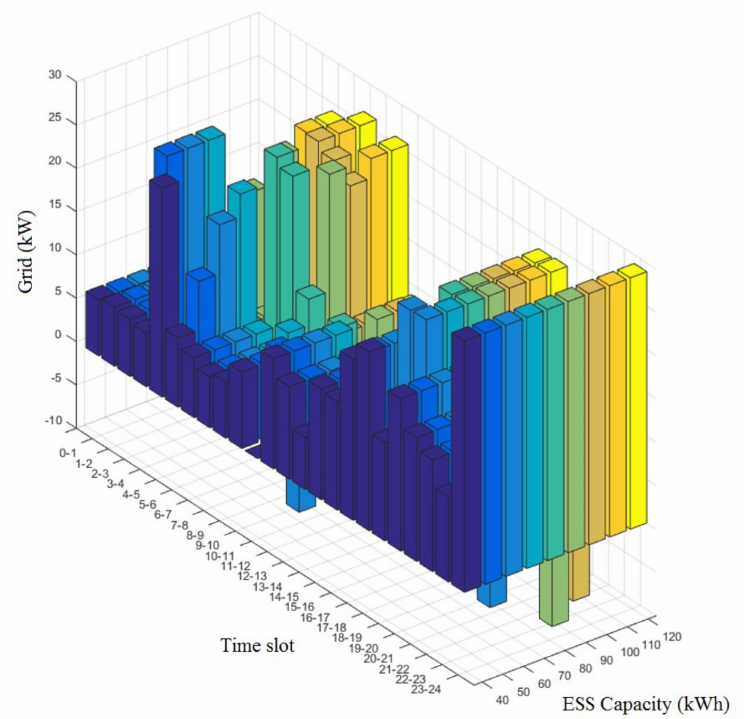
Figure 8. System power usage by ESS capacity (1).